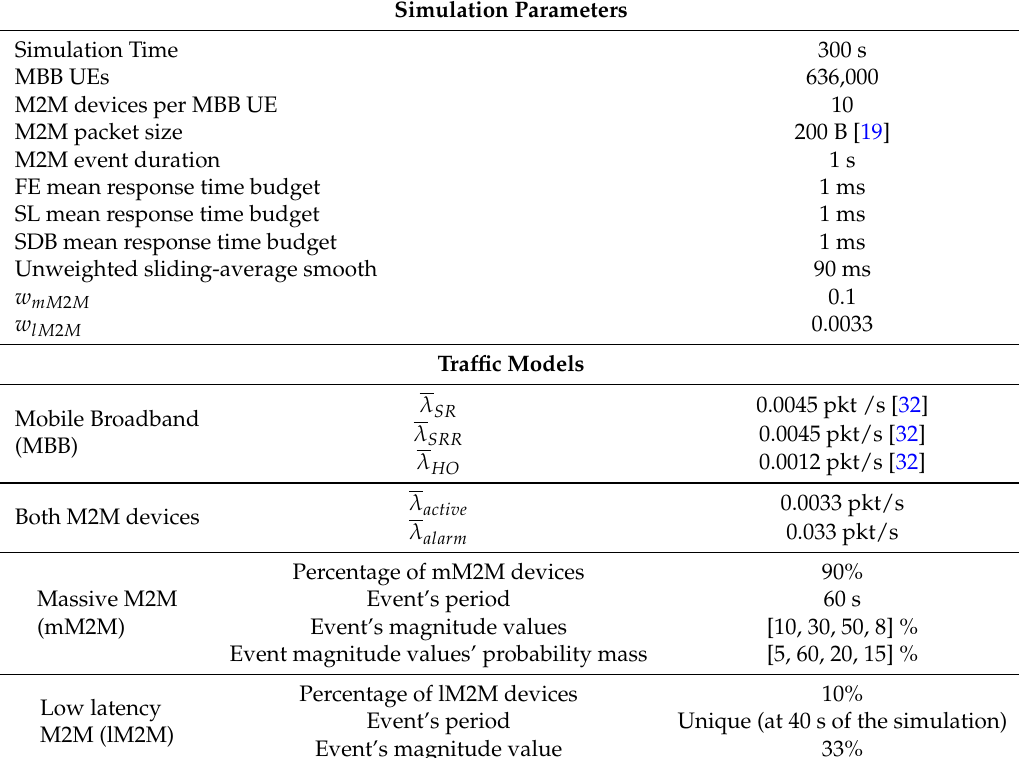
Table 4. Parameters’